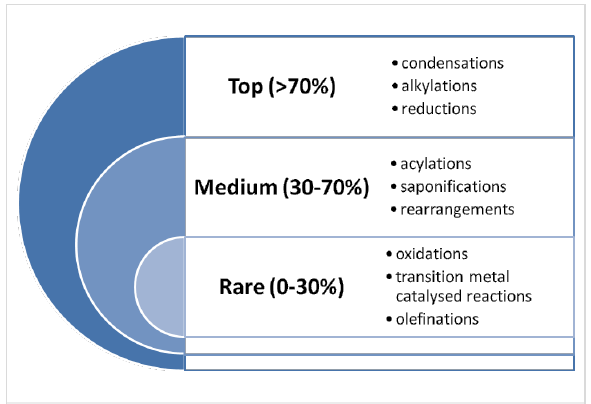
Figure 15: Relative abundance of selected